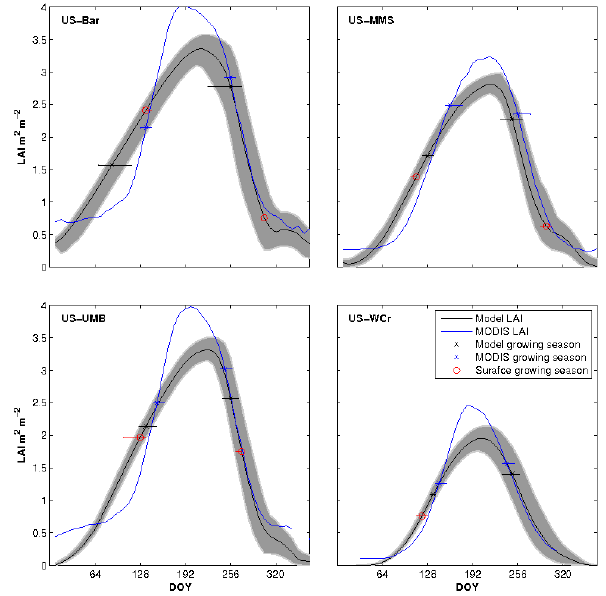
Fig. 9. Model and MODIS mean seasonal cycle. The start and end of the growing season are determined as the day on which the canopy reaches 50% development for model and MODIS; other metrics for ground-based estimates (see Table 1). Error bars represent min- imum and maximum yearly variation for the measurement